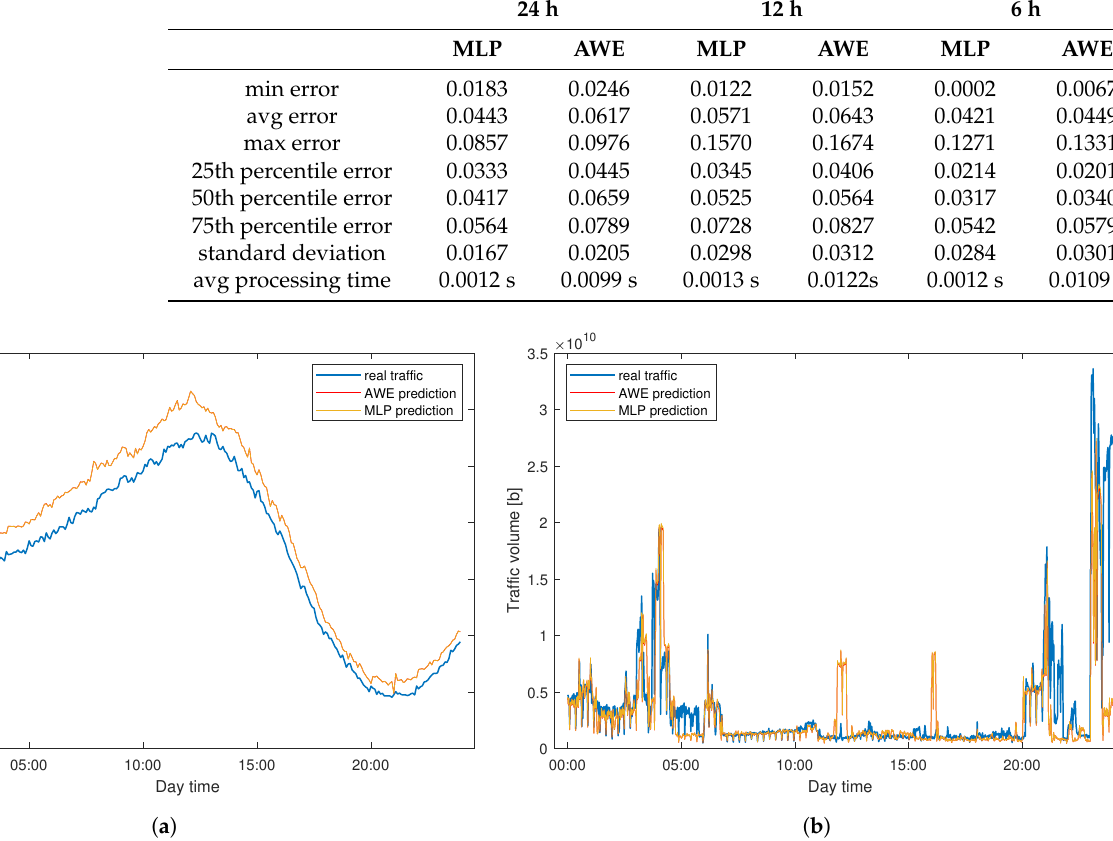
Figure 13. Efficiency of machine learning-based traffic prediction—observed and predicted traffic as a time function 2 January 2021. ( a ) SIX dataset, ( b ) WASK